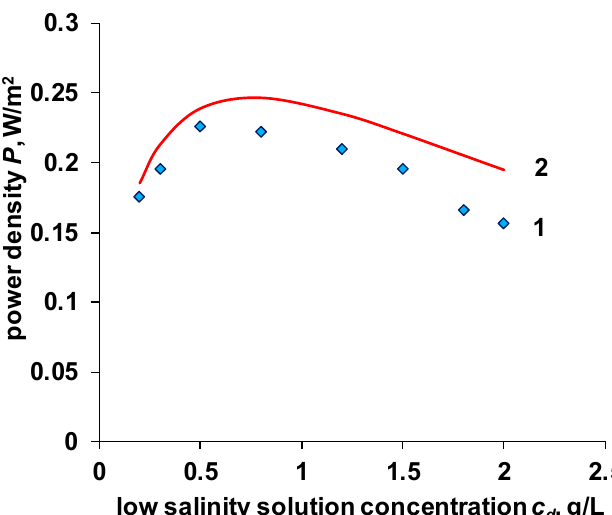
Figure 10. Dependence of power density on the salinity of the low concentration solution. 1–experimental data for the Ralex membrane pair, 2–calculation using Equation (20).